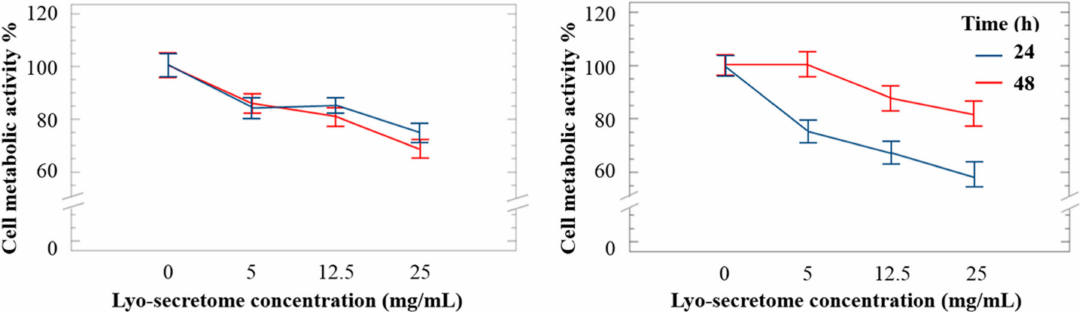
Figure 9. ( A ) Cell metabolic activity of human fibroblasts and ( B ) human chondrocytes treated with different doses of lyo-secretome after 24 (blue line) and 48 (red line) h. Mean values ± LSD ( n = 3), ANOVA.